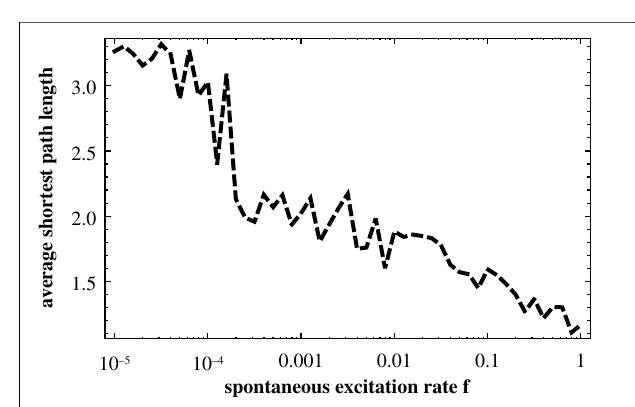
FIGURE 10 | Average shortest path length for effective networks formed by susceptible elements at each time step of the numerical simulation of the dynamics. In order to compute this curve for each value of f we used a 10,000 time step simulation of the dynamics on the 256-node hierarchical graph, for each effective network averaged over the shortest paths between all nodes and, fi nally, averaged over the effective networks from 1000 time